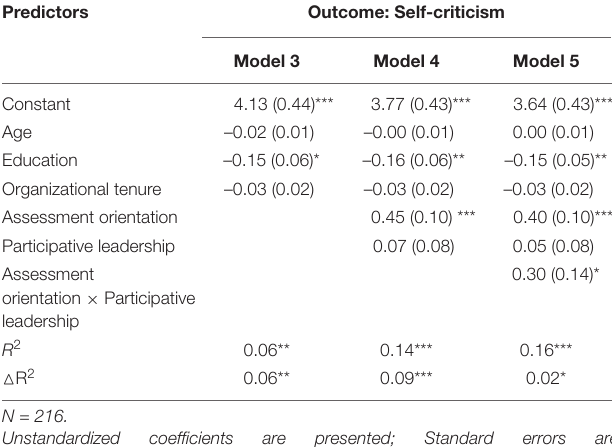
TABLE 4 | The mediating effect of self-criticism.